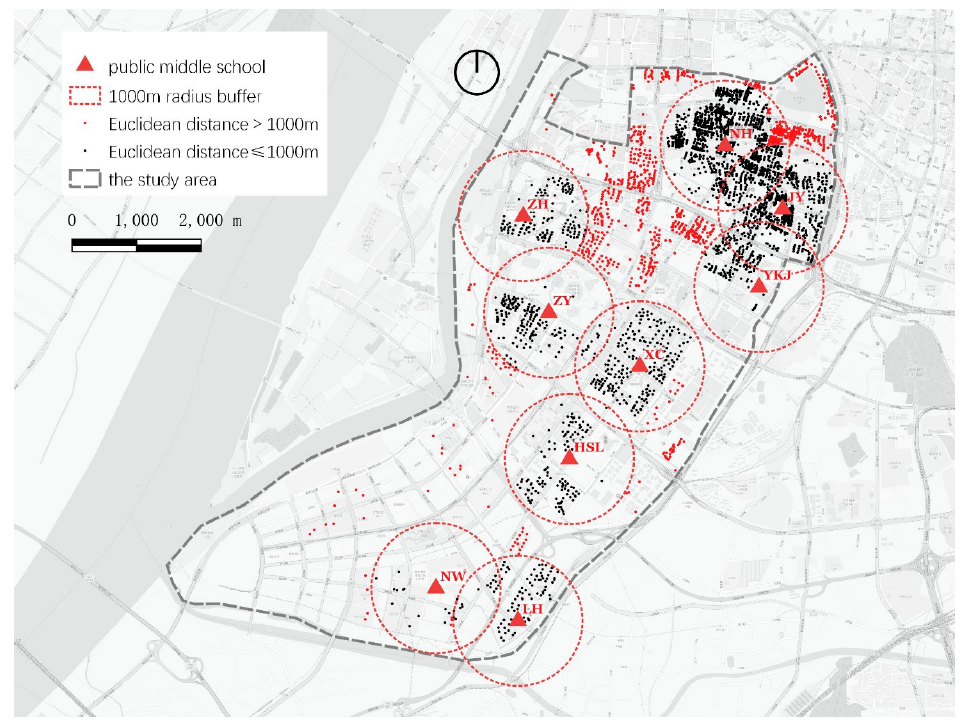
Figure 4. Residence points division by threshold of Euclidean distance (1000 m).